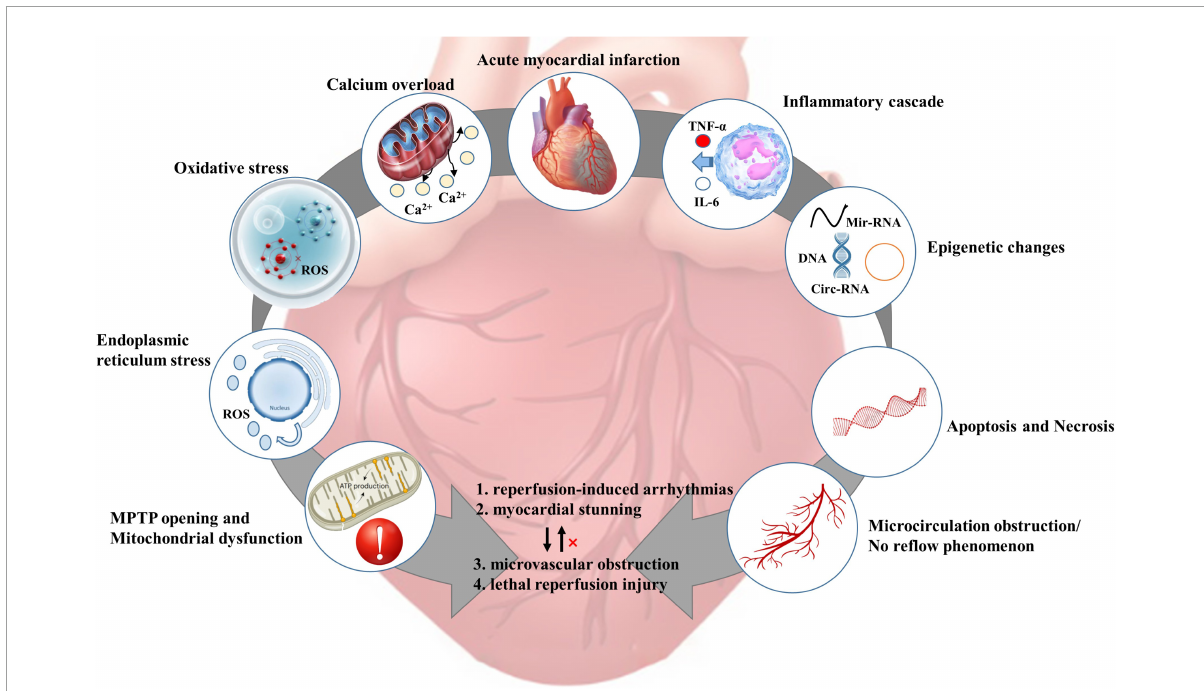
FIGURE3 Pathophysiological mechanism of myocardial ischemia-reperfusion injury [adapted from Heusch et al. (4)]. ROS, reactive oxygen species; MPTP, mitochondrial permeability transition pore; TNF- α , tumor necrosis factor- α ;IL-6, interleukin-6.